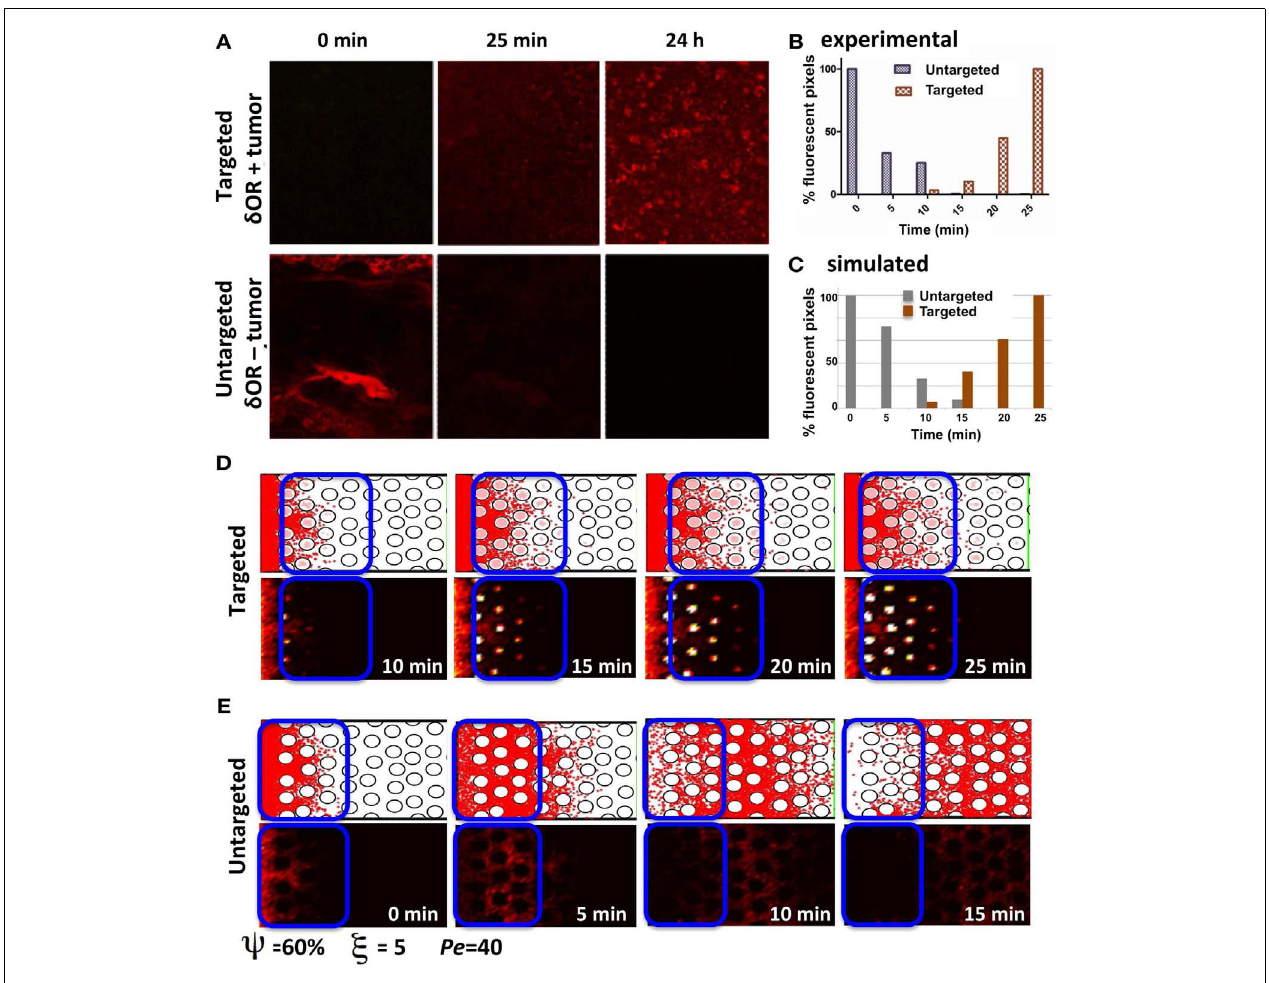
quantification of the simulated results from the section of the tissue indicated as a blue window in (D , E) .The simulated data has been normalized as in (B) for comparison. (D) The time sequence from a simulation with cellular uptake via receptor binding (targeted); the top images show individual particles, and the bottom images show the corresponding fluorescent rendering. (E) Time sequence from a simulation without cellular uptake (untargeted). Both simulations were run for the same tissue structure with a cellular density of ξ = 5, cellular porosity of ψ = 60%, and Péclet number of Pe =